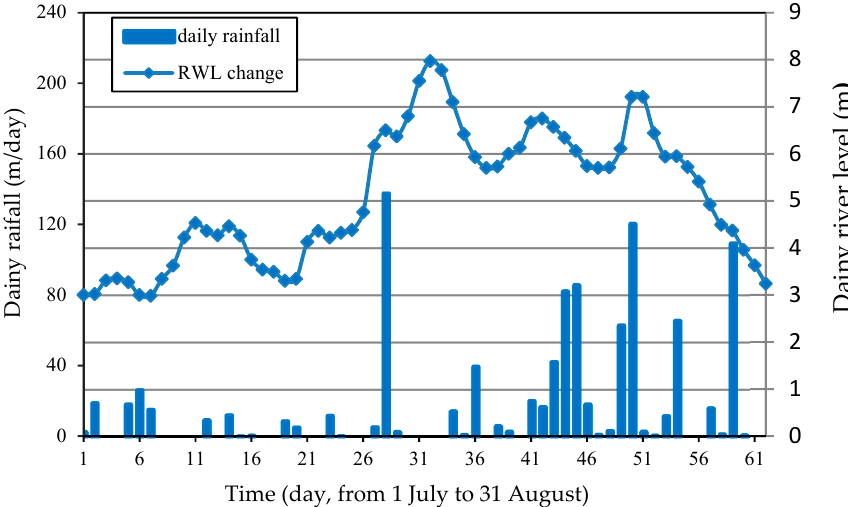
Figure 5. The hourly rainfall with high rainfall intensity for some days in August 2016.